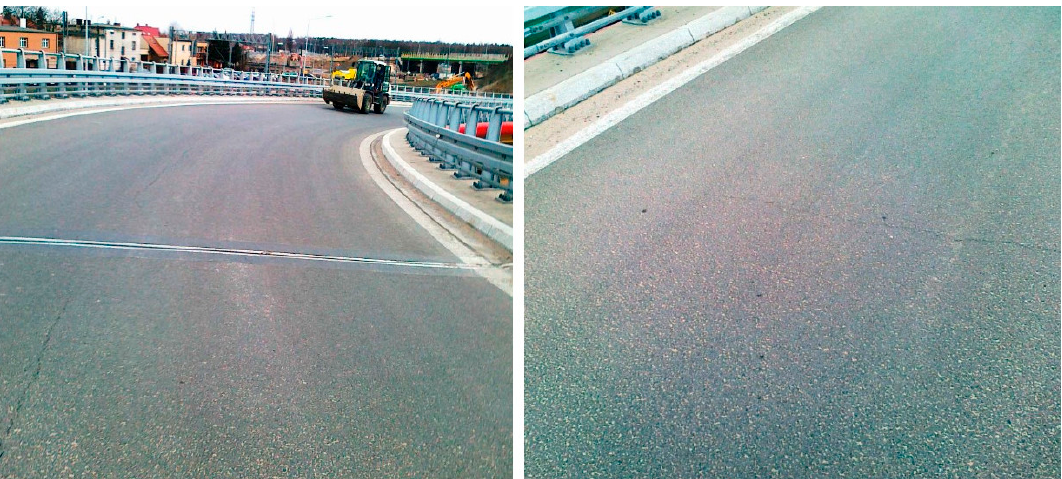
Figure 4. Distressed wearing course due to shrinkage and cracking of the protective layer of mastic asphalt.